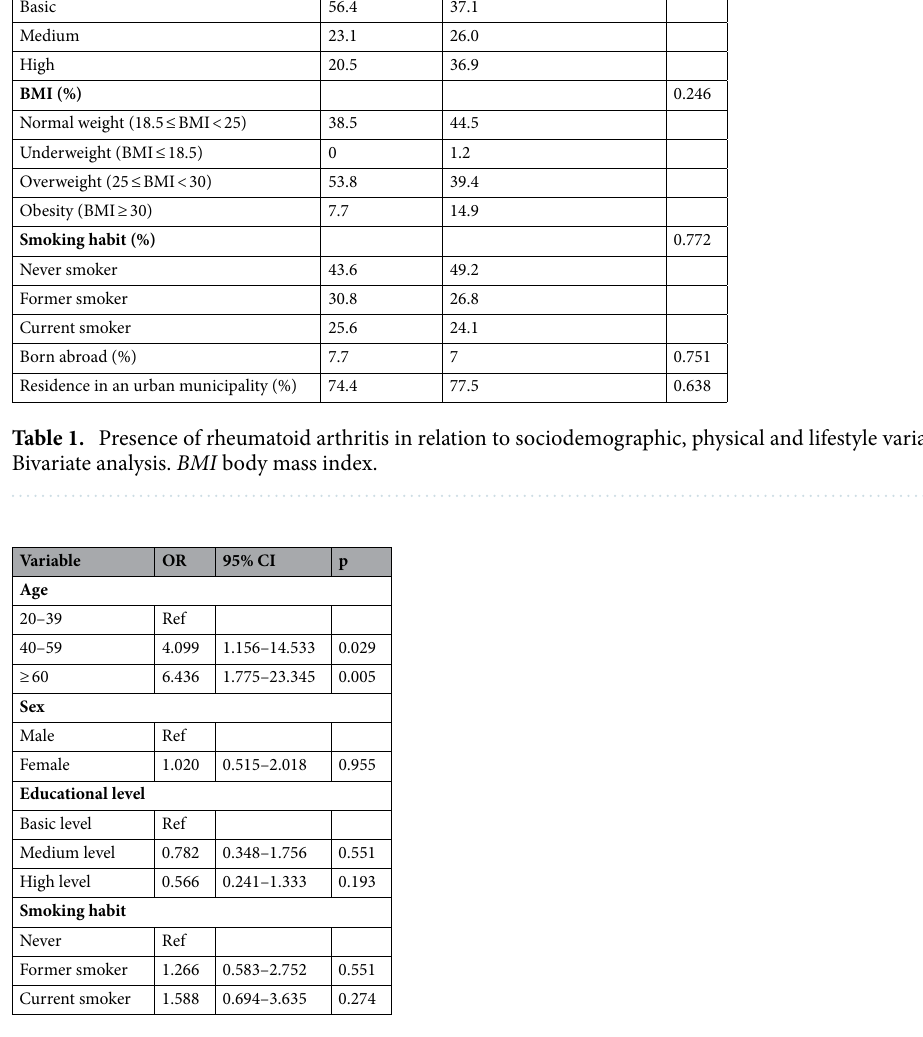
Table 2. Multivariable analysis. Variables associated with the presence of rheumatoid arthritis. OR odds ratio, CI confidence